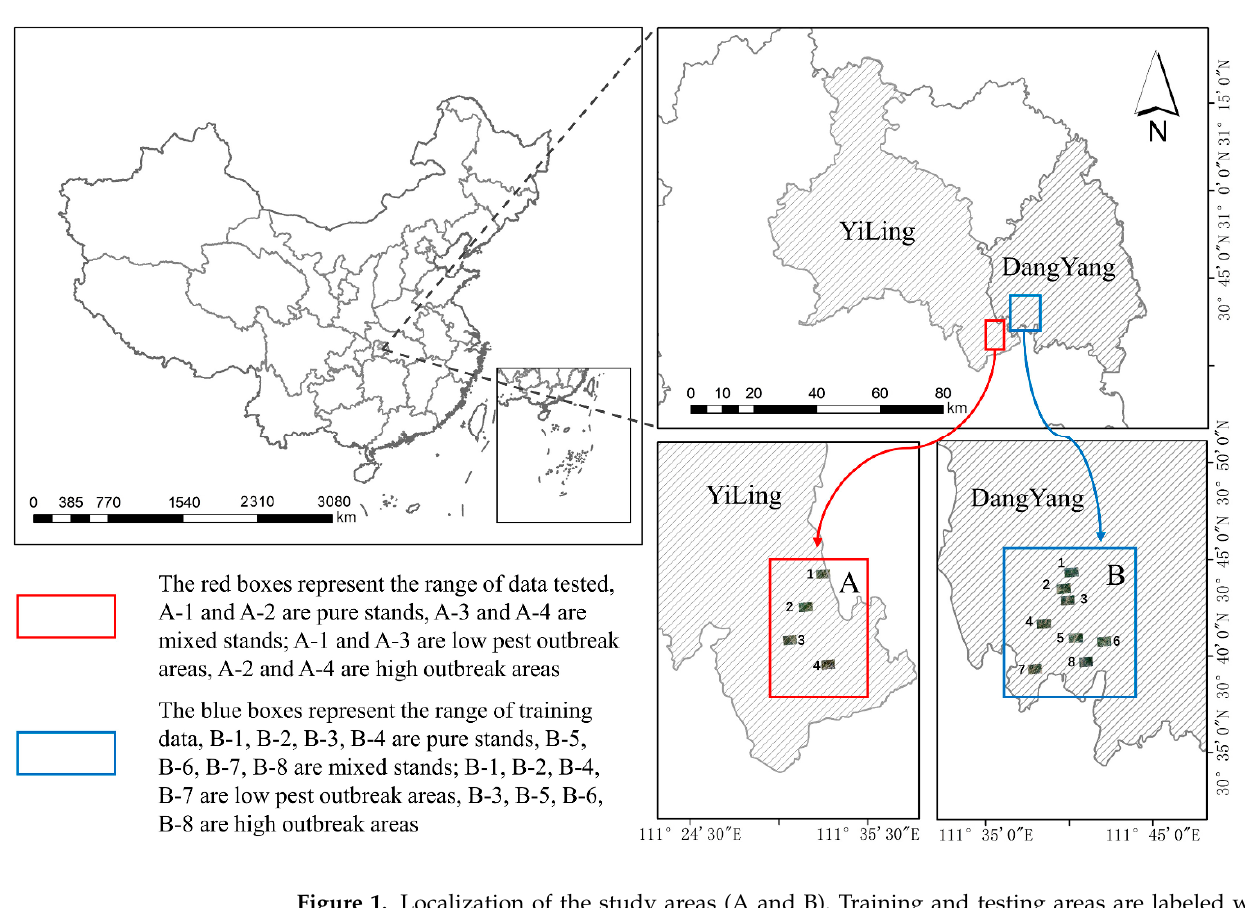
Table 2. Statistical information of standing dead trees in site B.